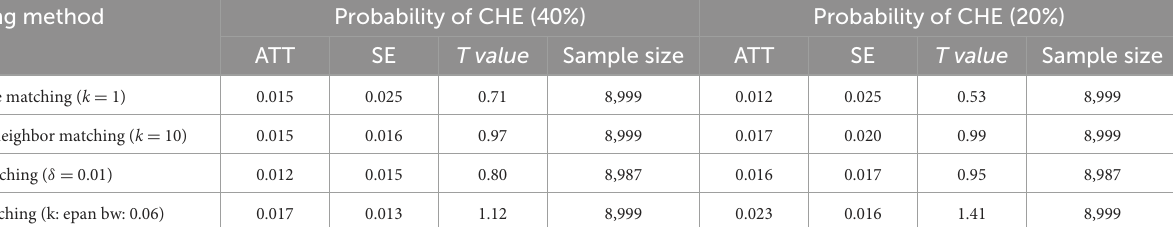
TABLE 5 The impact of MFA on catastrophic healthcare expenditures (CHEs). Matching method Probability of CHE (40%) ATT T value Sample size Sample